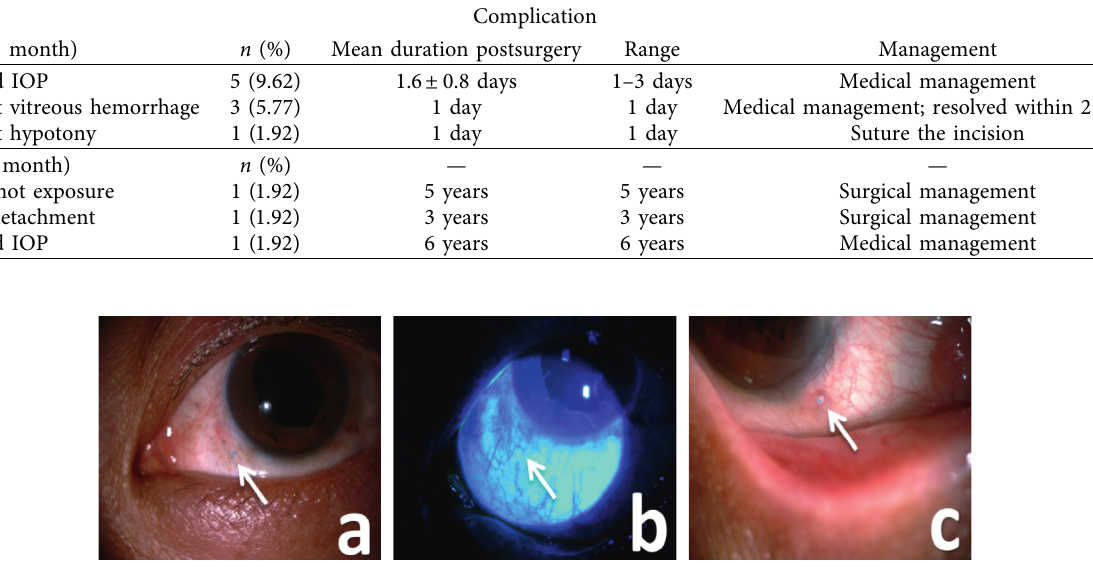
Figure 3: Slit-lamp microscopy images of the suture knot. (a) Suture knot visible under the conjunctiva. (b) Negative bulbar conjunctival fluoresce staining. (c) Suture exposure 5 years